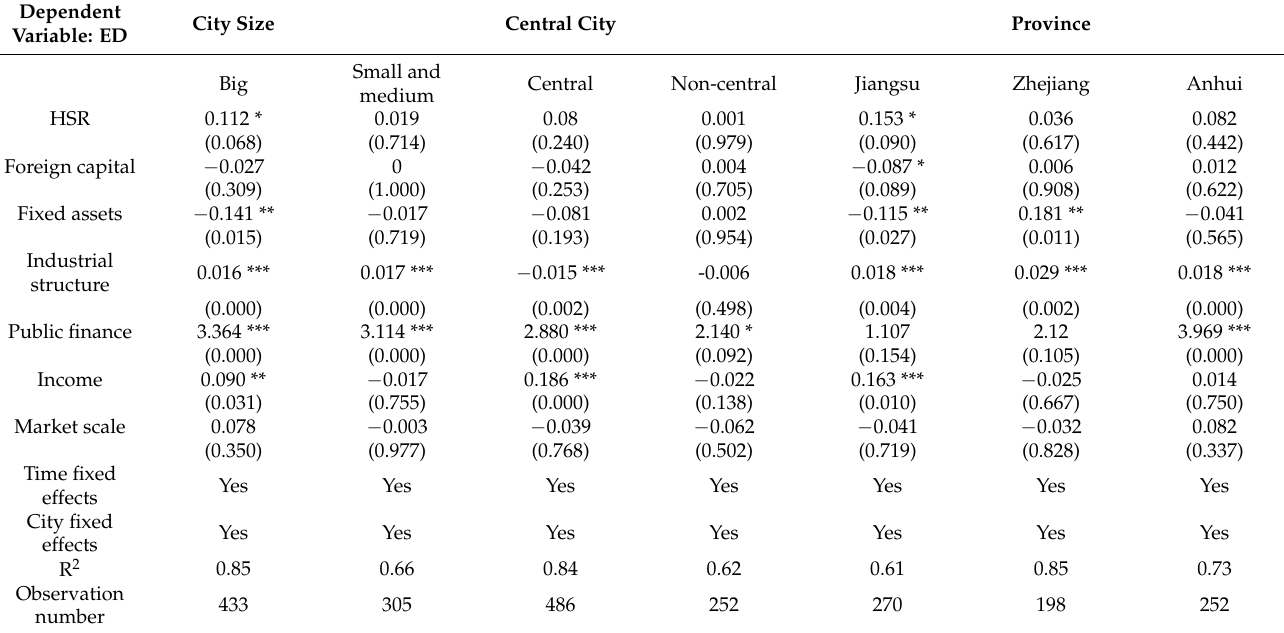
Table 3. Heterogeneity analysis of the impact of HSR on economic